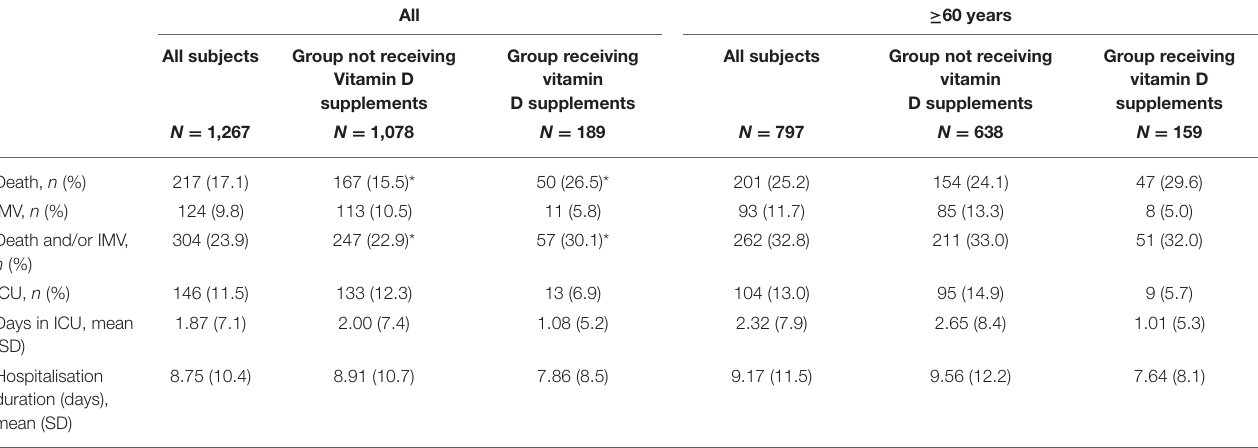
TABLE 2 | Intra hospital events overall and according to Vitamin D supplements in the whole study population and in the subgroup of 60 years or